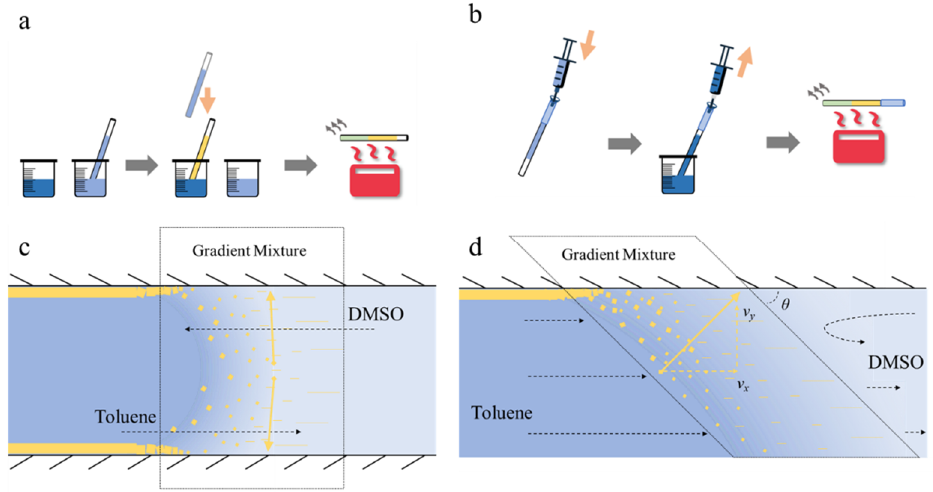
Figure 3. Solvent exchange film assembly methods. ( a ) A dipping method incorporating the spontaneous solvent exchange crystal forming and deposition. ( b ) The fast solvent exchange film assembly incorporating external force. ( c , d ) The proposed physical pictures for the respective methods. With a fluid velocity in the x -direction, the crystal deposition direction is rotated by θ .